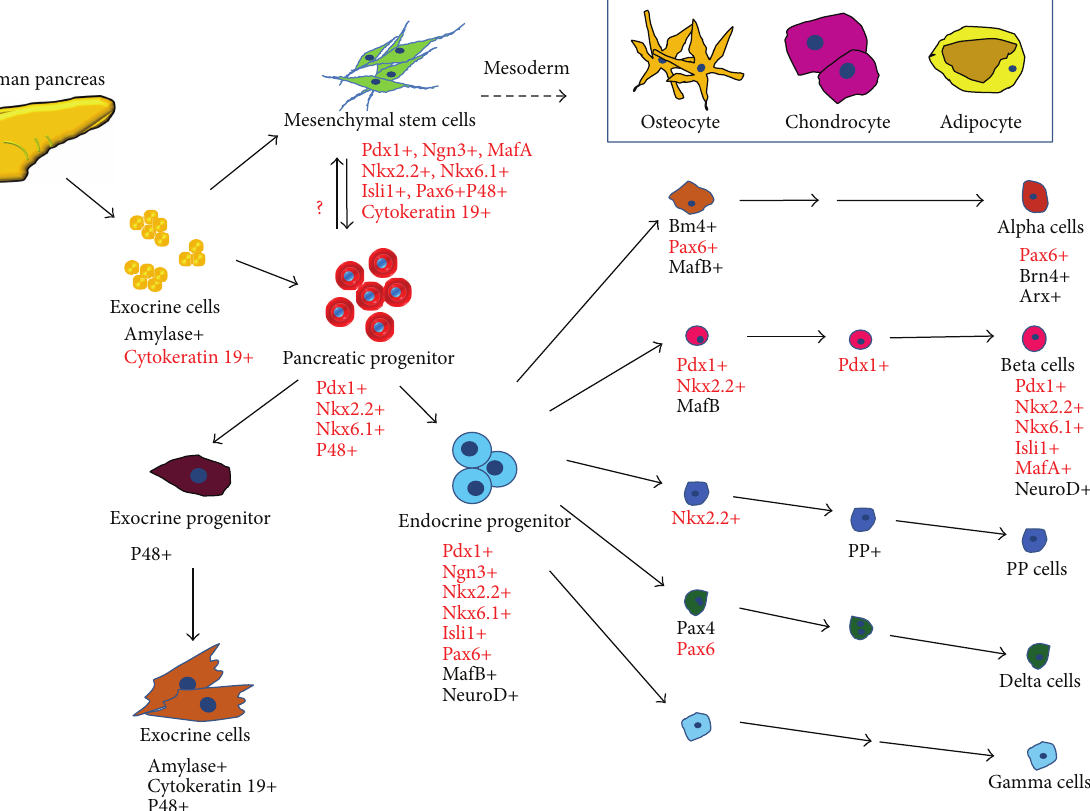
Figure 6: Correlations between transcription factor expressions in hpMSCs and in pancreas progenitor cells. Human exocrine pancreas tissue-derived hpMSCs express Pdx1, Nkx2.2, Nkx6.1, and P48 at levels comparable to those in pancreatic progenitor cells. hpMSCs also specifically express other factors, including Ngn3, Isl1, Pax6, and MafA, associated with pancreas-endocrine developmental lineage.